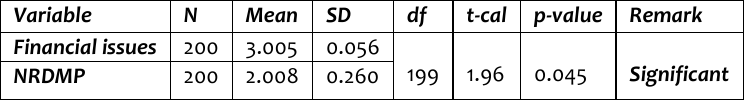
Table 3 : t-test summary on the financial issues for numerical